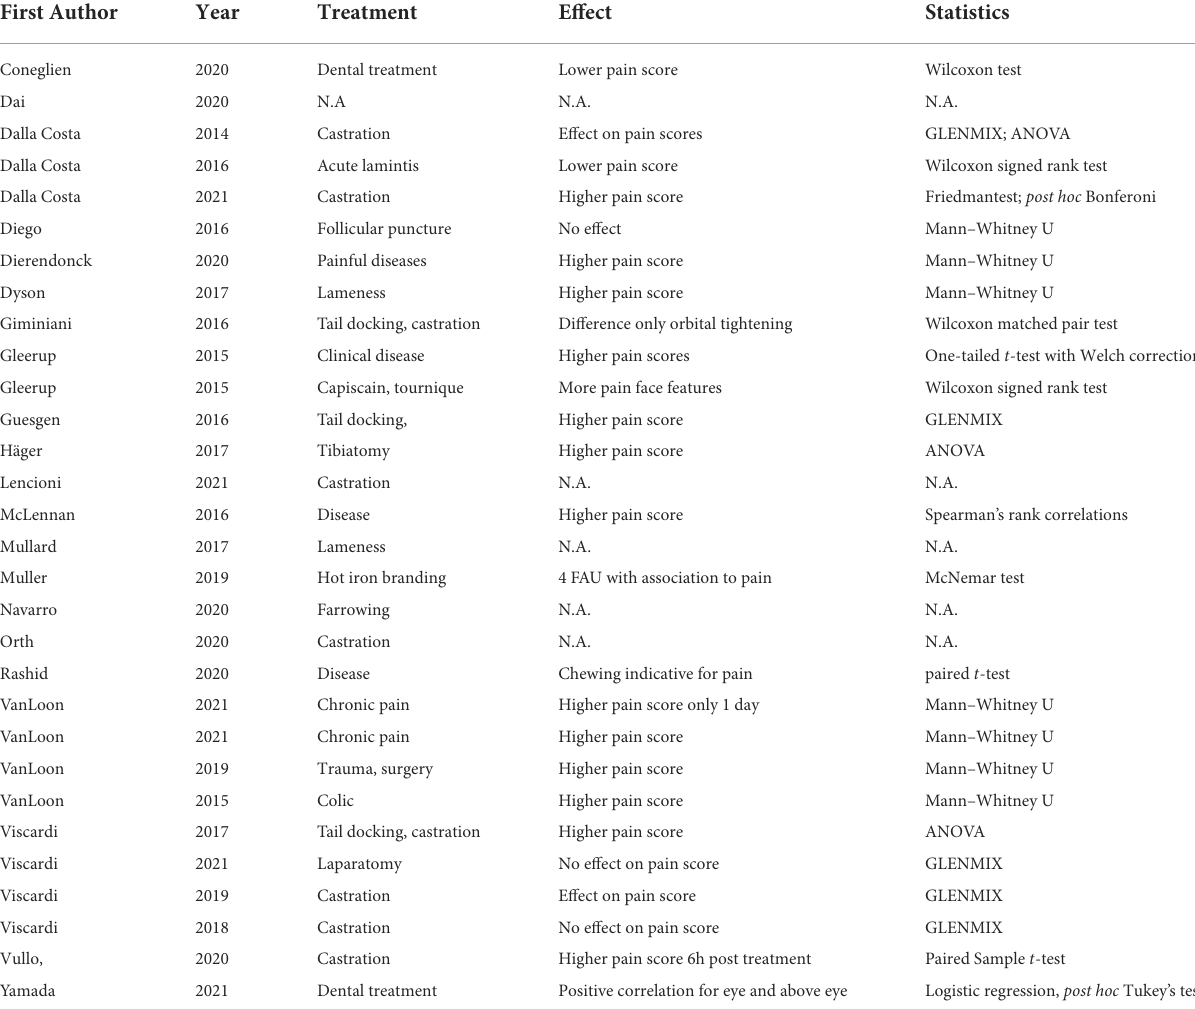
TABLE 2 Effect of treatment on facial expressions and statistical methods used for